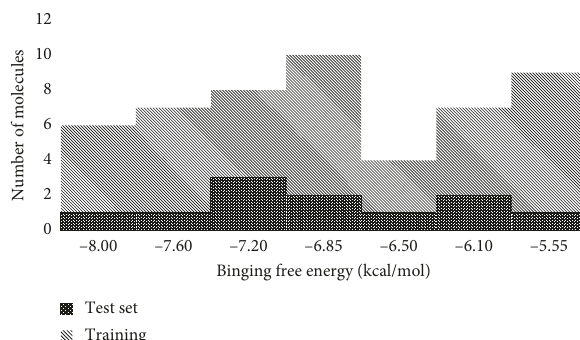
Figure 5: Distribution of binding free energy values of the whole